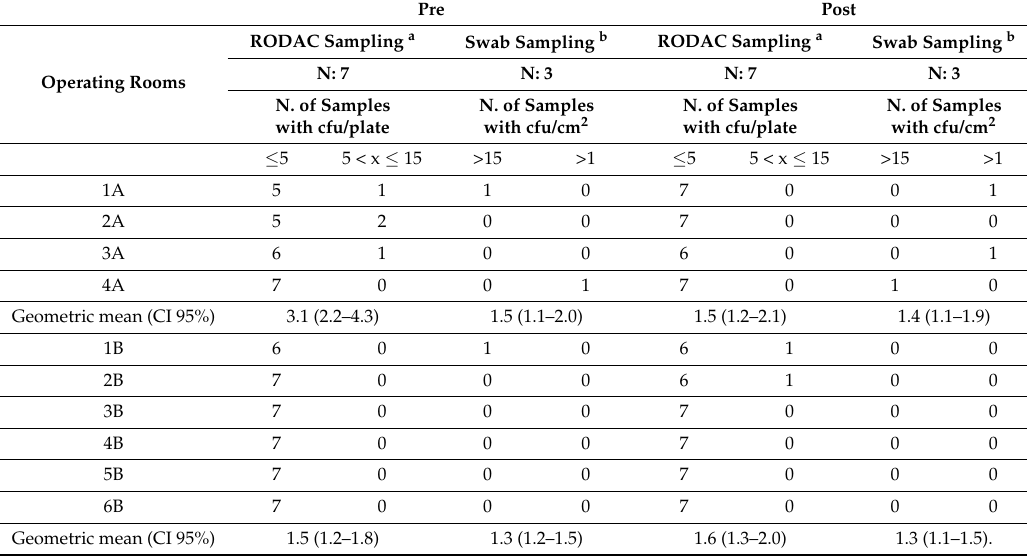
Table 2. Total Viable Count (TVC) in the surfaces of the operating rooms monitored “at rest”, in two moments of the same daily operating session (Pre and Post). Distribution of samples in the different contamination classes, geometric means and confidence intervals (CI 95%). Pre Post RODAC Sampling a Swab Sampling b RODAC Sampling a Swab Sampling b